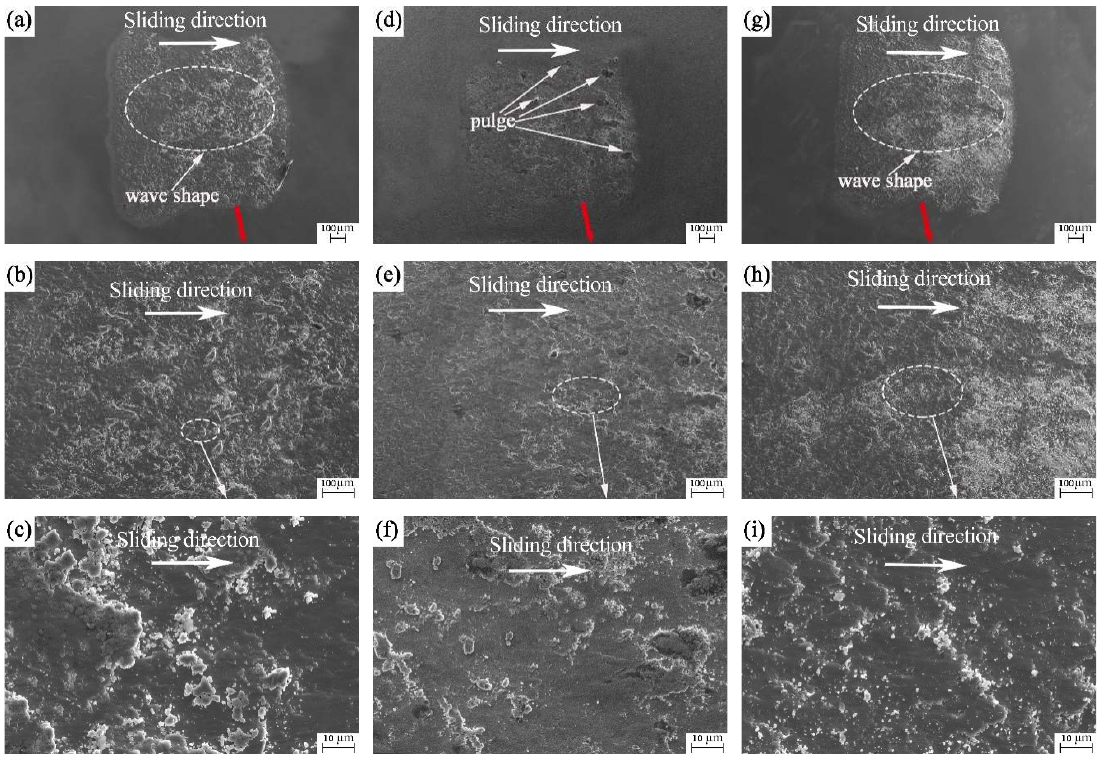
Figure 14. SEM images of the femtosecond-textured worn balls: ( a – c ) rotation radius 15 mm; ( d – f ) rotation radius 18 mm; and ( g – i ) rotation radius 22.5 mm.